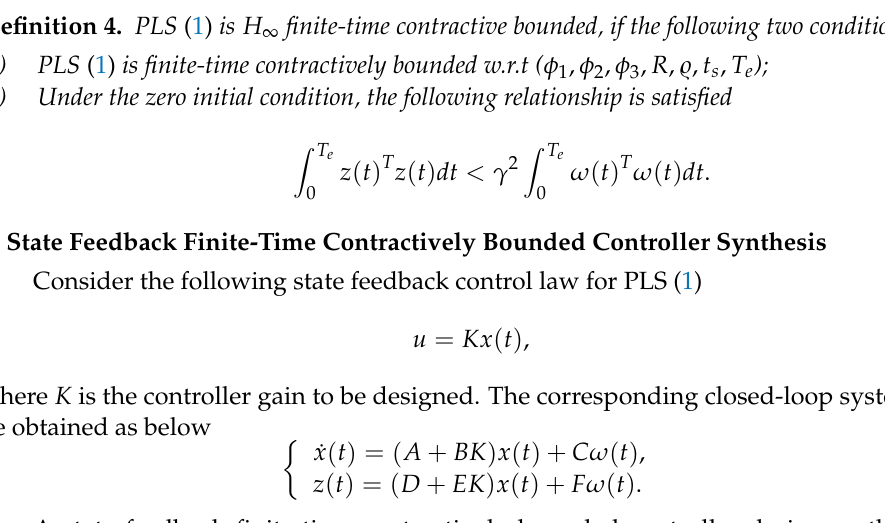
Figure 1. Illustration of Definition